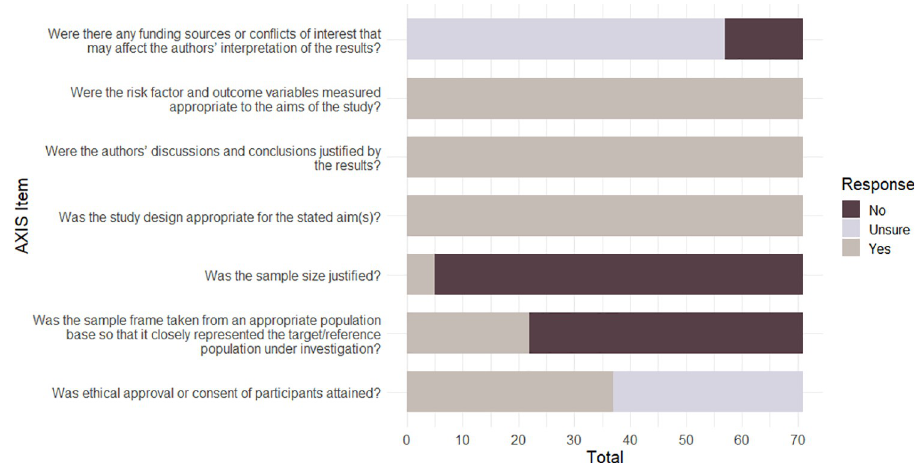
Fig 3. AXIS study design quality summary for the 71 papers included in the